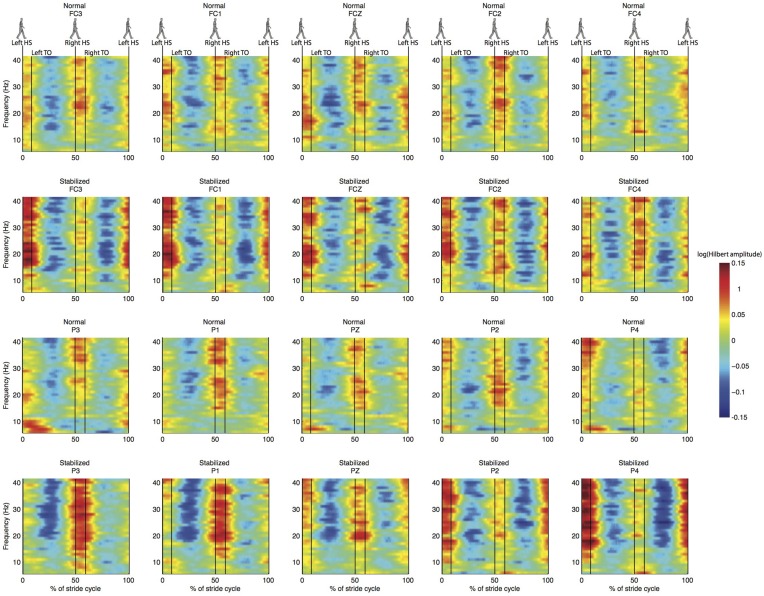
Normalized ERSP for the same electrodes as in Figure 4. First and third row are for normal walking, second and fourth for stabilized walking.